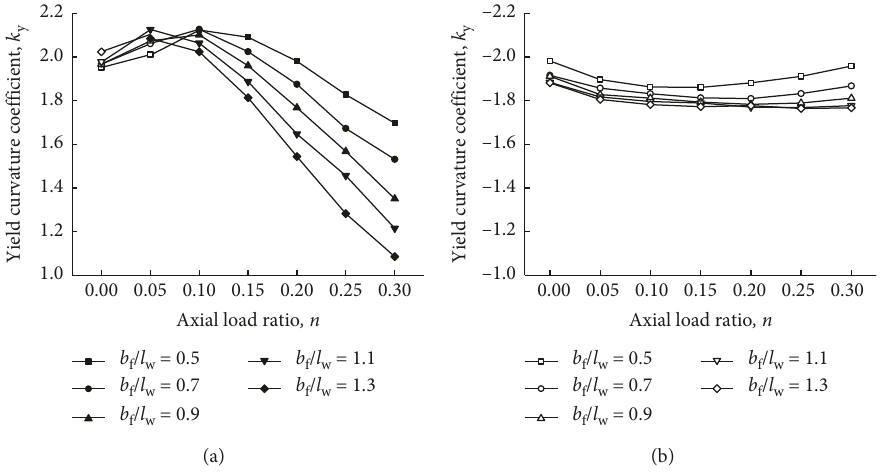
Figure 10: Variations in the yield curvature coefficient with the axial load ratio at different flange width to web height ratios. (a) Flange in tension. (b) Flange in compression.